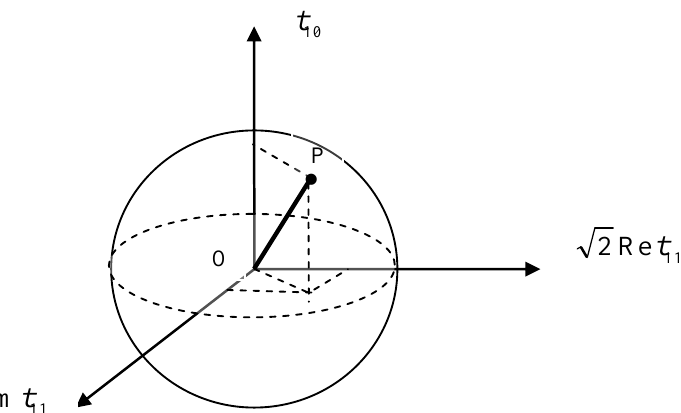
Figure 11. Geometrical representation of possible vector polarization states. The vector polarization state is determined by the point P in the sphere and the degree of vector polarization by the length of vector OP : D v = R v / 2, R v = OP . The maximum radius of the sphere is R max v =